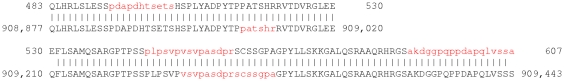
Alignments between a protein and the human genome.This shows two local alignments between a protein (Q494U1, upper sequence) and human chromosome 1 (lower sequence). Lowercase red letters were masked by tantan. The upper alignment was found with gentle masking, but not with harsh masking.